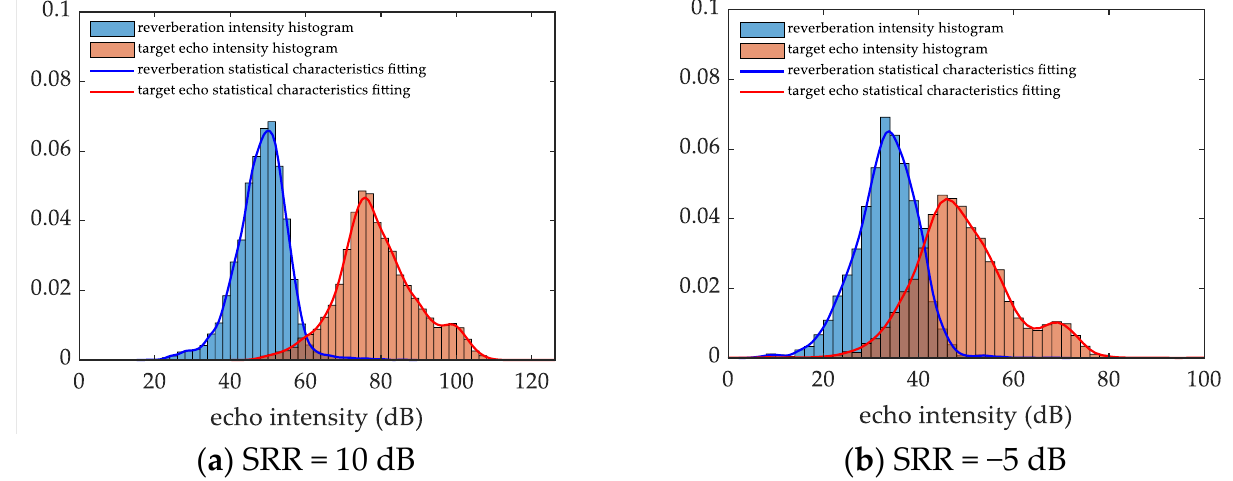
Figure 4. The reference trajectory.